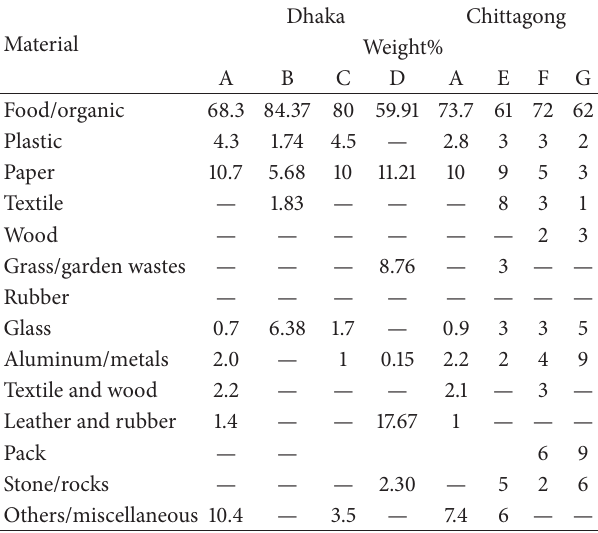
Table 3: Typical MSW characteristics of Dhaka and Chittagong city. Material